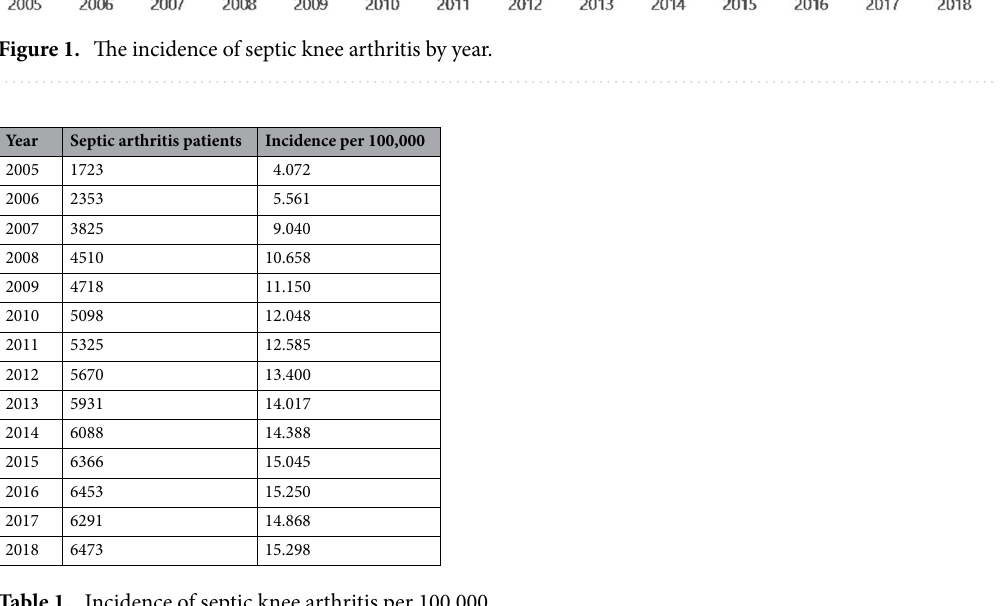
Table 1. Incidence of septic knee arthritis per